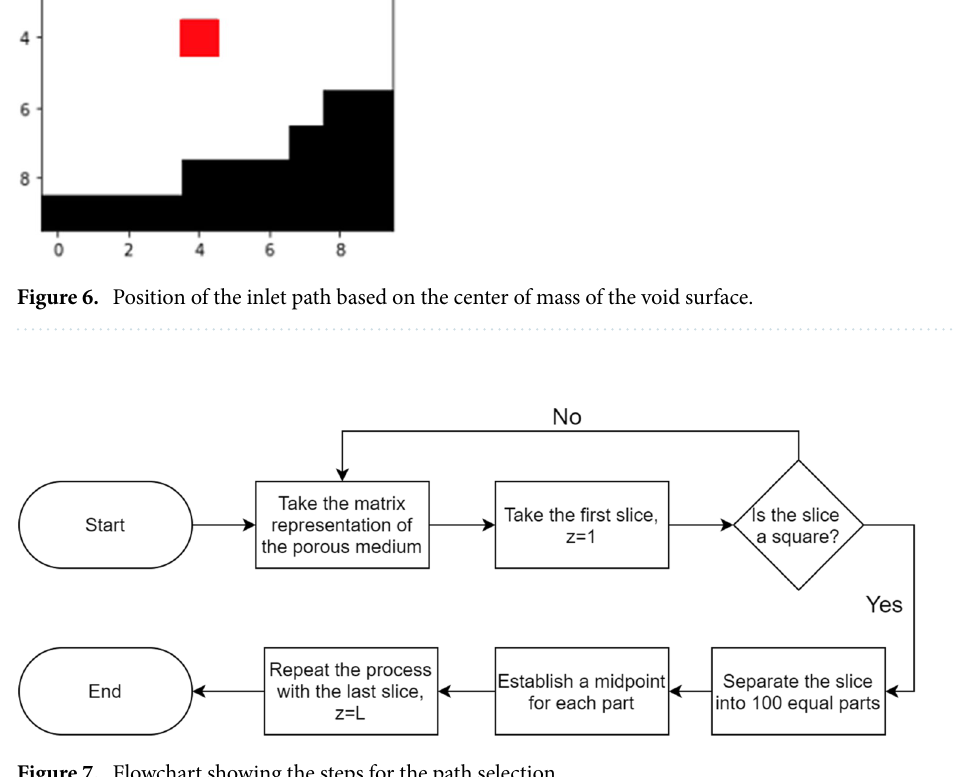
Figure 7. Flowchart showing the steps for the path